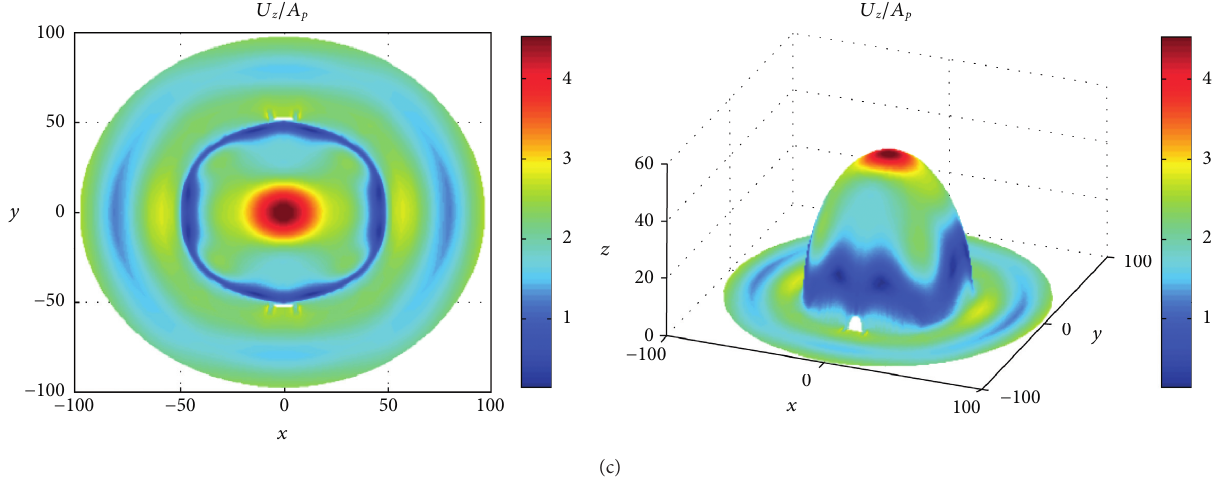
Figure 5: Surface displacement amplitude of the 3D tunnel mountain under the incident P wave ( η � 2 . 0 , α � 0 ° ): (a) surface displacement amplitude in x direction; (b) surface displacement amplitude in y direction; (c) surface displacement amplitude in z